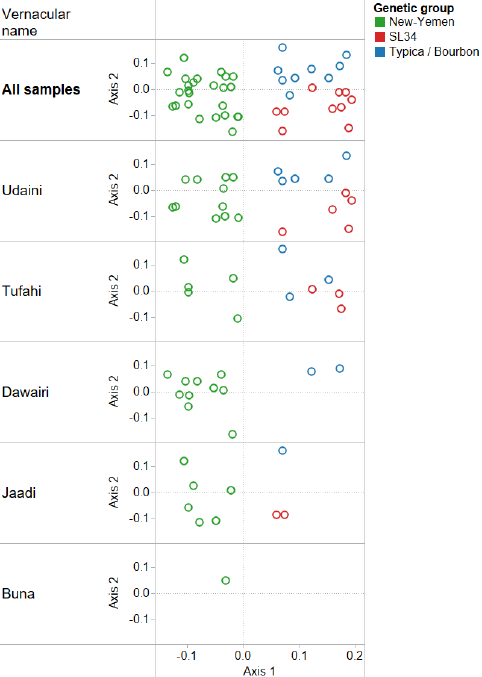
Figure 5. Representation of 88 coffee samples on the first two components of the PcoA based on their SSR profile. The first row includes all the samples, and subsequent rows show samples of each vernacular name separately. The color of each point corresponds to the different genetic groups.